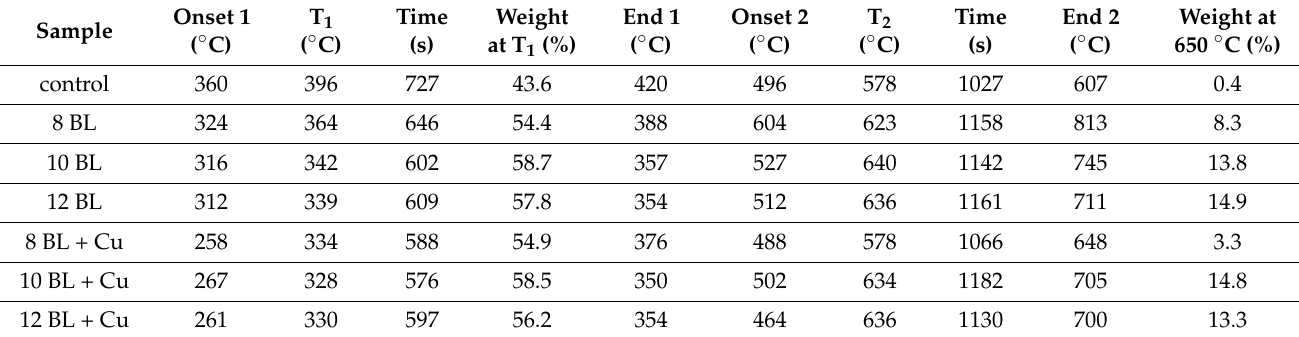
Figure 3. TGA curves for untreated (control) and 8, 10, 12 BL PA/CH-urea-treated samples. Table 4. Summary of thermogravimetric analysis of untreated and LbL-treated cotton.